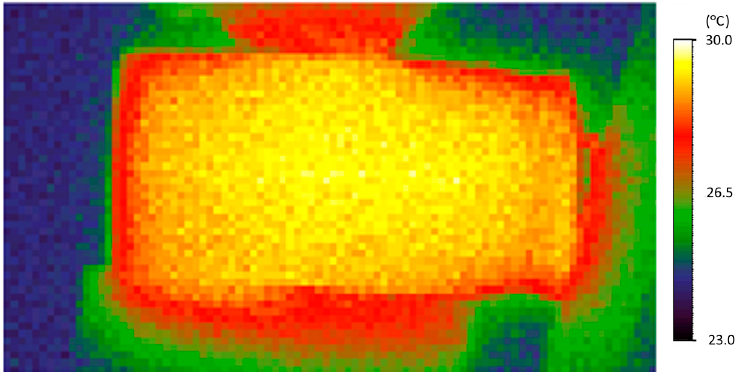
Figure 6. Typical image of a single sample thermogram during the test process for U = 2.7 V, I = 1400 mA.